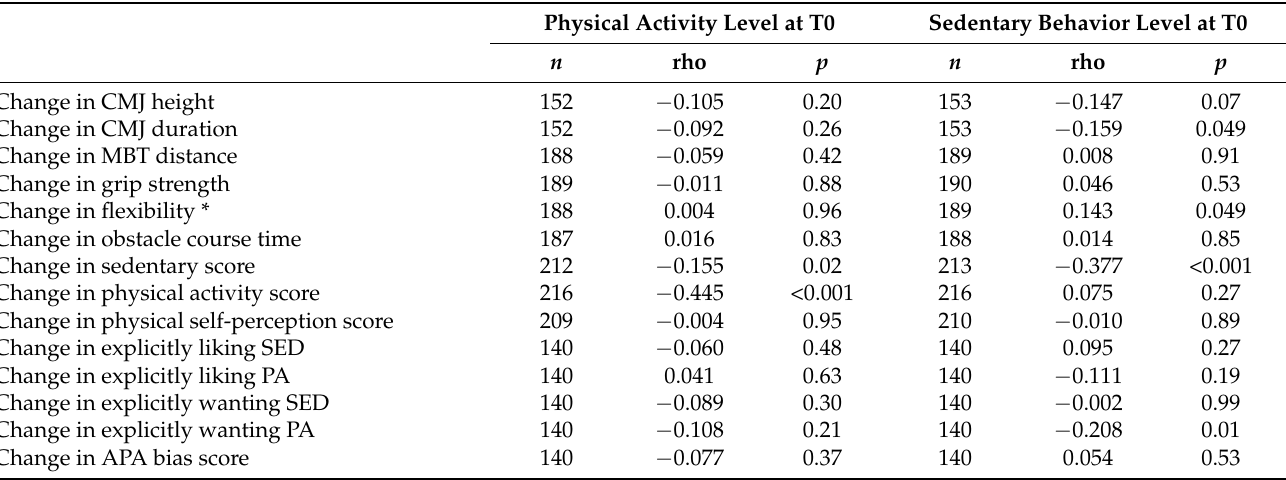
Table 3. Correlations between the baseline levels of the physical activity and sedentary behaviors of the children (Globe Trotter group only), and change in each of the parameters studied between baseline (T0) and one month later (T1). Physical Activity Level at